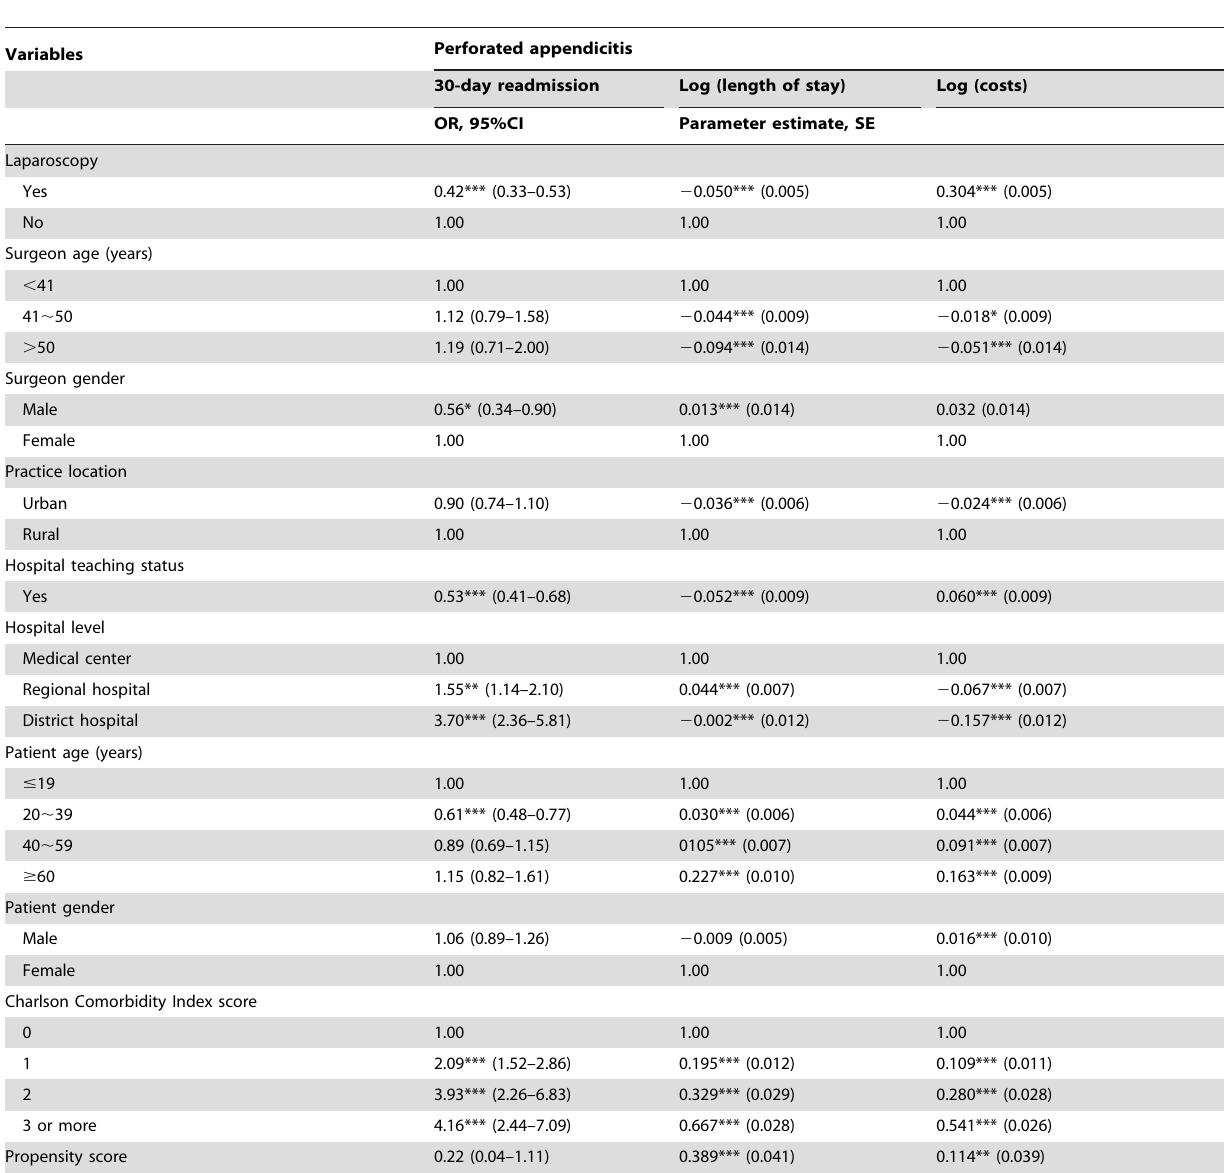
Table 4. Adjusted relationships between 30-day readmission, length of stay, cost per discharge, and the use of laparoscopy for patients with perforated